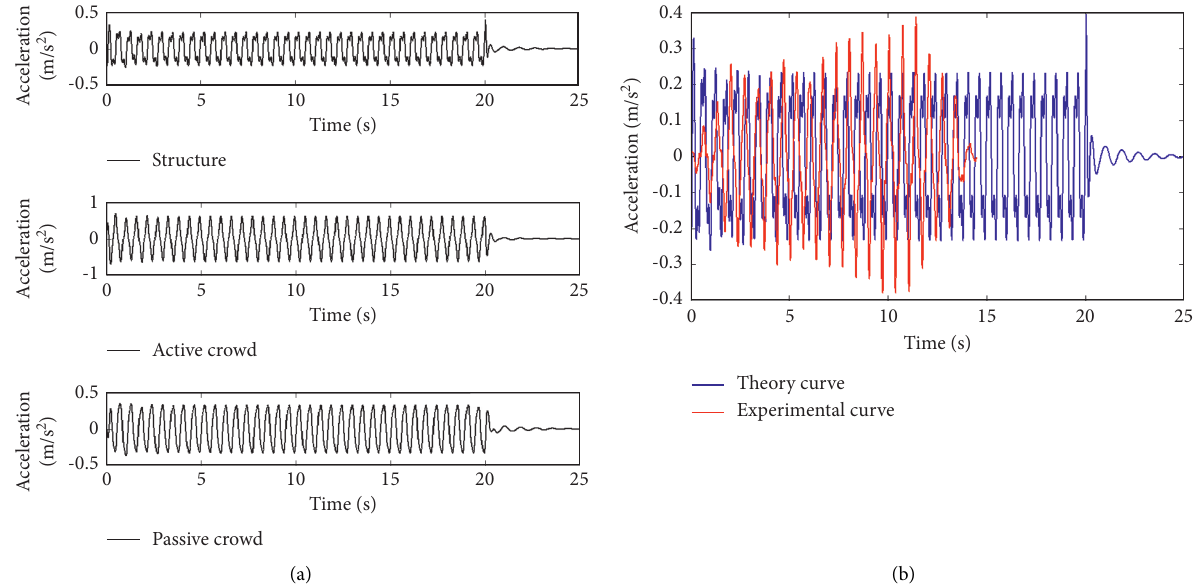
Figure 14: The simulated acceleration of model at swaying load. (a) The acceleration of model; (b) the theory acceleration and experimental acceleration of